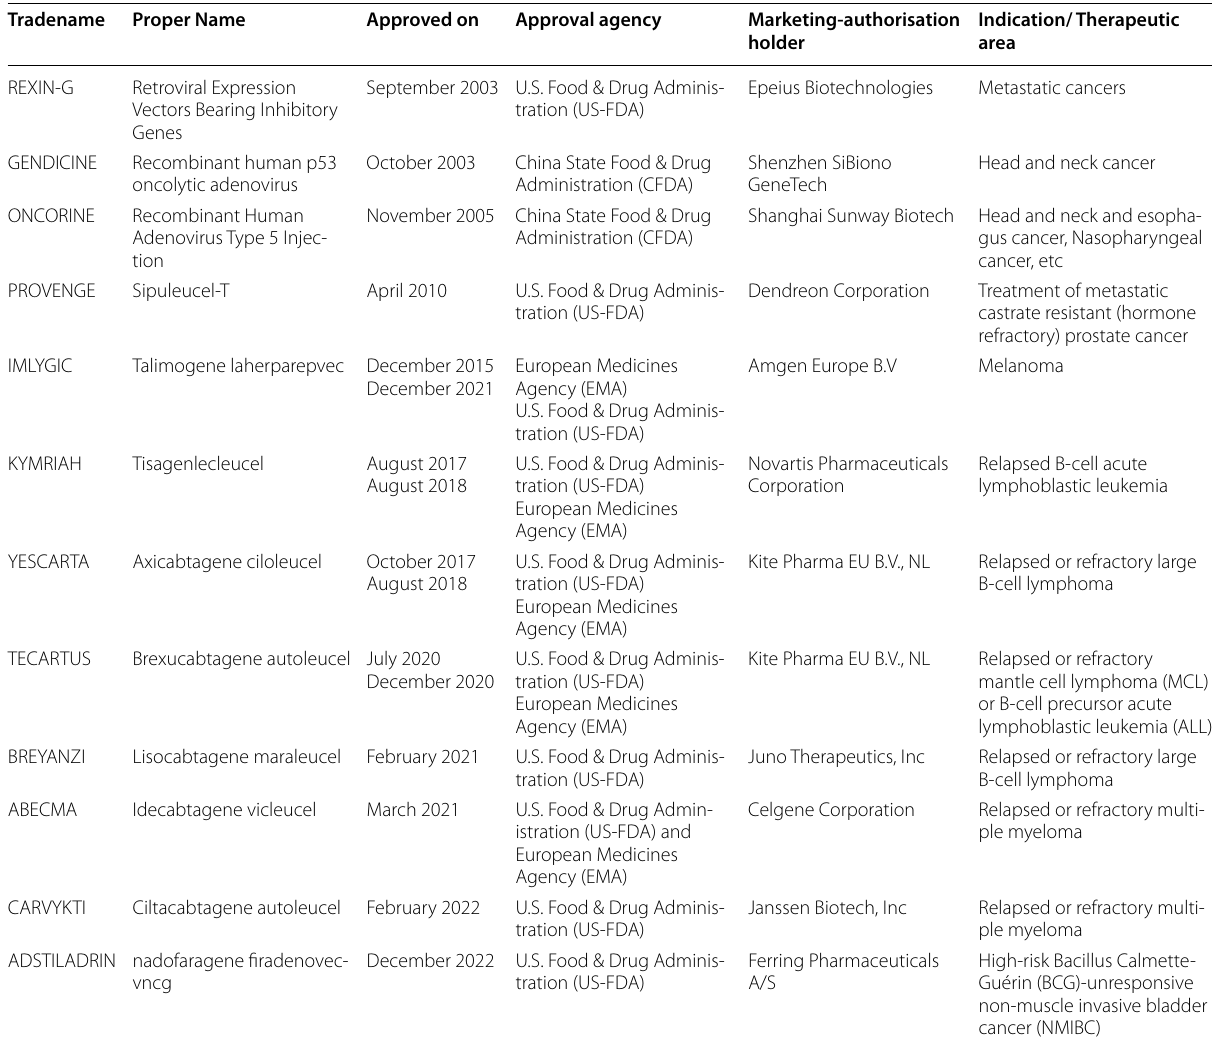
Table 2 Currently approved Gene Therapy Products for Cancer